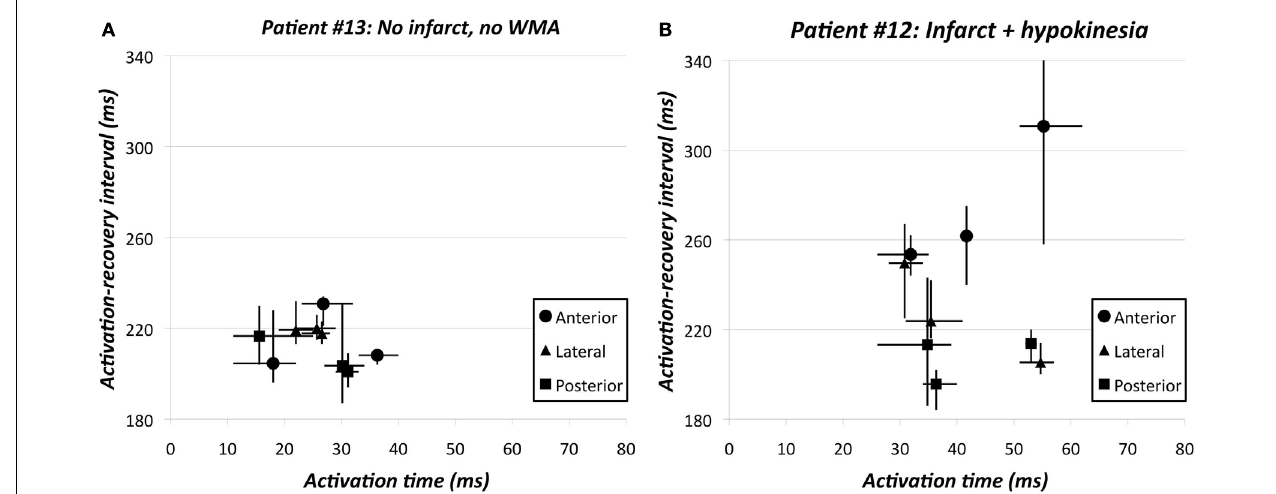
dispersion in activation times and activation-recovery intervals in each of the nine regions.The huge dispersion primarily results from the very long activation-recovery intervals in the apical anterior region.The three posterior/inferior regions were all hypokinetic, leading to wall motion score 3 in this patient.The posterior/mid region had the shortest activation-recovery